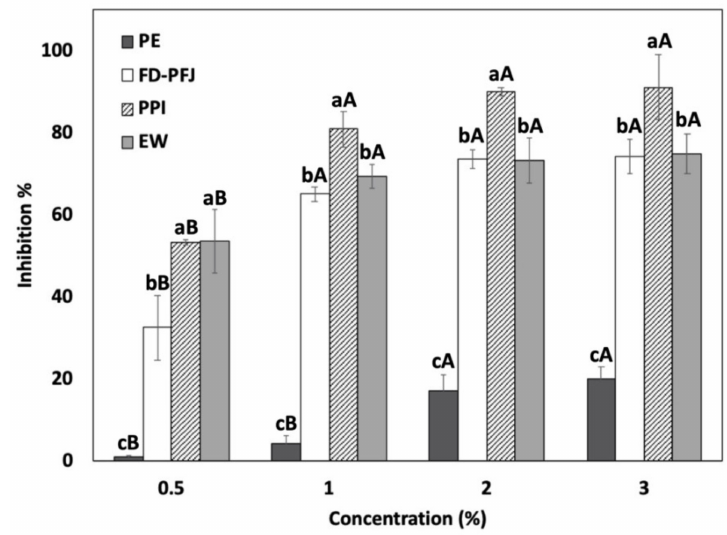
Figure 1. Autolysis inhibition of Pacific whiting surimi with four different inhibitors at various con- centrations (PE, potato extract; FD-PFJ, freeze-dried potato fruit juice; PPI, potato protein isolate; and EW, egg white). A significant difference ( p < 0.05) among the inhibitors with the same concentration is denoted by lowercase letters and a significant difference ( p < 0.05) by various concentrations in each inhibitor is denoted by capital letters.